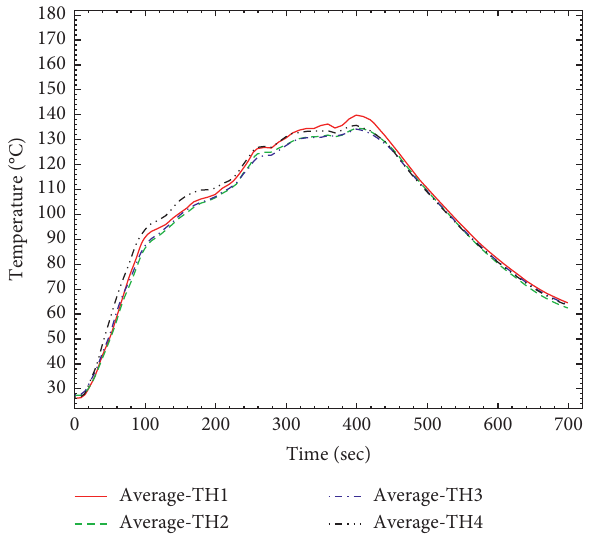
Figure 13: Temperature of hot gases under ceiling of the PFC configuration.